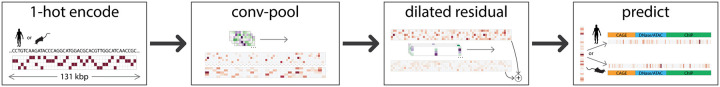
Predicting regulatory sequence activity for human and mouse genomes.We predict the regulatory activity of DNA sequences for multiple genomes in several stages (Methods). The model takes in 131,072 bp DNA sequences, encoded as a binary matrix of four rows representing the four nucleotides. We transform this representation with seven iterated blocks of convolution and max pooling adjacent positions to summarize the sequence information in 128 bp windows. Green and purple heatmaps represent convolution filter weights; red and white heatmaps represent pooled sequence vectors. To share information across the long sequence, we apply eleven dilated residual blocks, consisting of a dilated convolution with exponentially increasing dilation rate followed by addition back into the input representation. Finally, we apply a linear transform to predict thousands of regulatory activity signal tracks for either human or mouse. All parameters are shared between species except for the final layer.